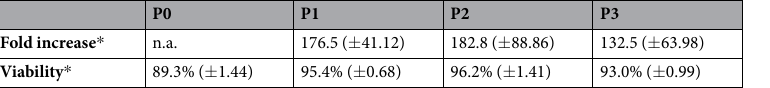
Table 1. hBM-MSC growth (fold increase) and viability (%) according to the expansion phase. Fold increase and viability were assessed from P0 to P3 passages. * Values are expressed as mean ± SE of four distinct hBM- MSC expansion experiments obtained from distinct